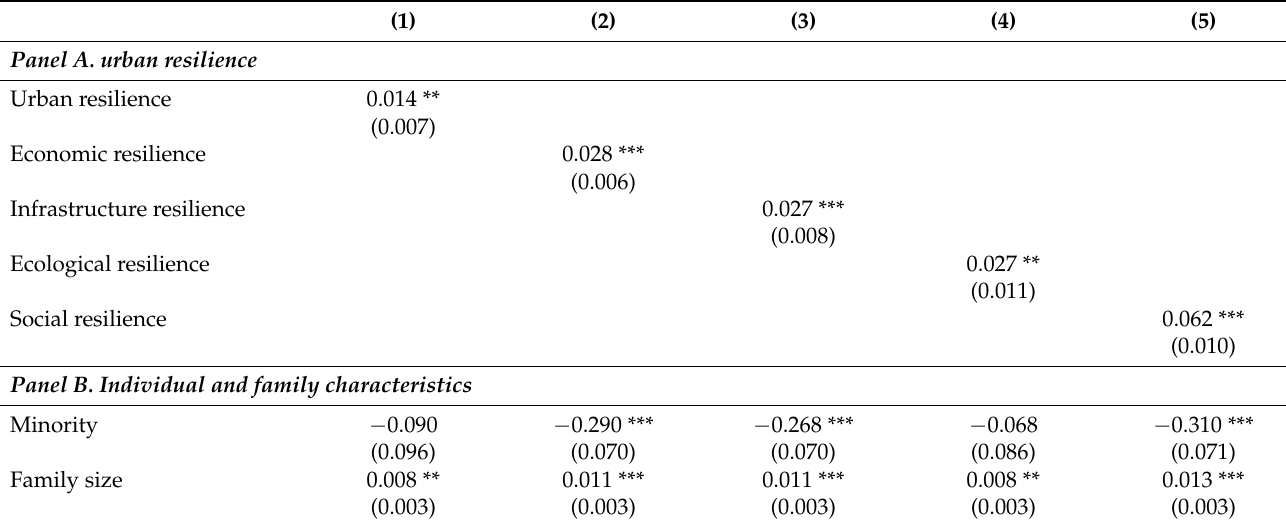
Table 3. Effect of urban resilience on residents’ subjective happiness 1